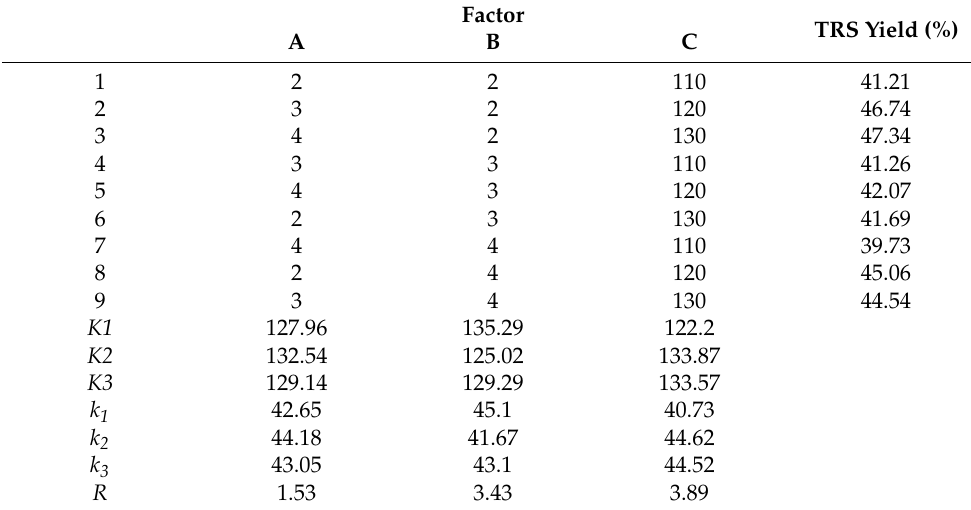
Table 3. Orthogonal analysis of alkali pretreatment